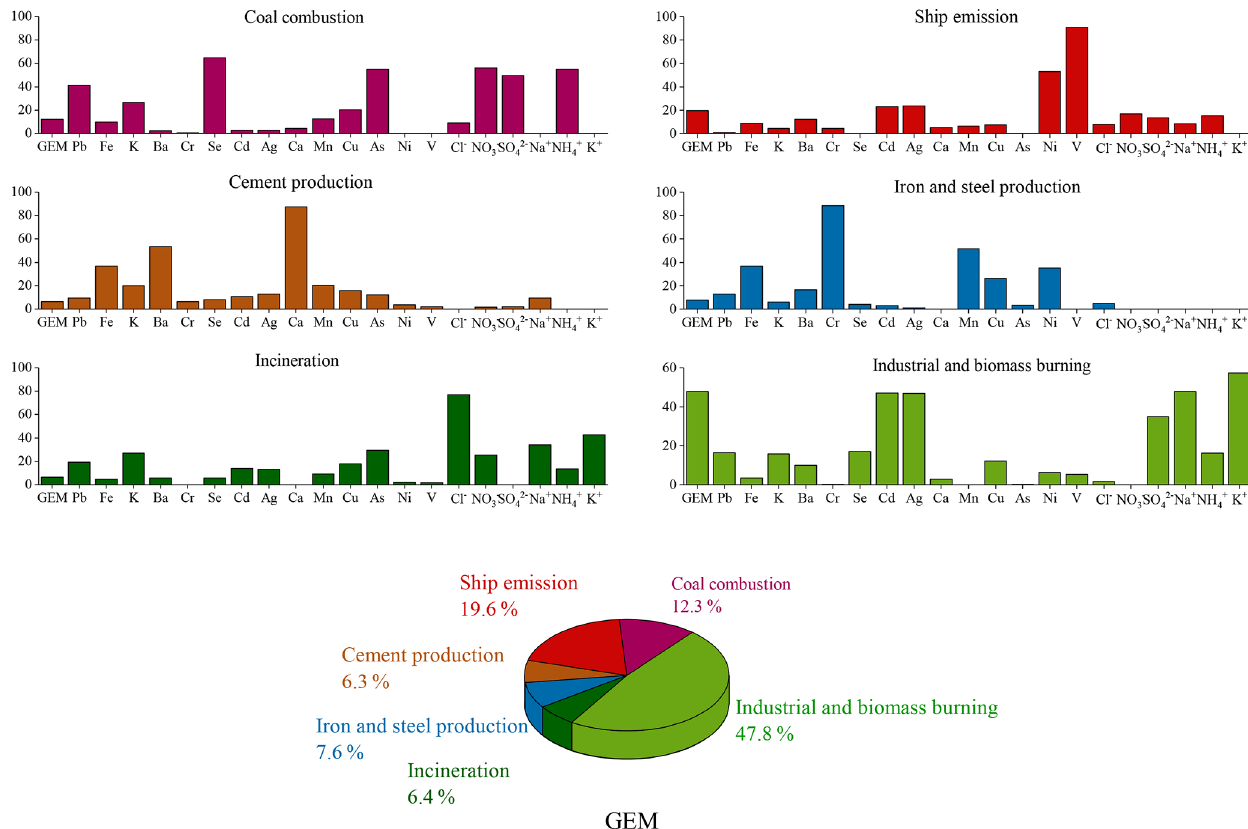
Figure 10. A six-factor source apportionment for anthropogenic GEM based on PMF